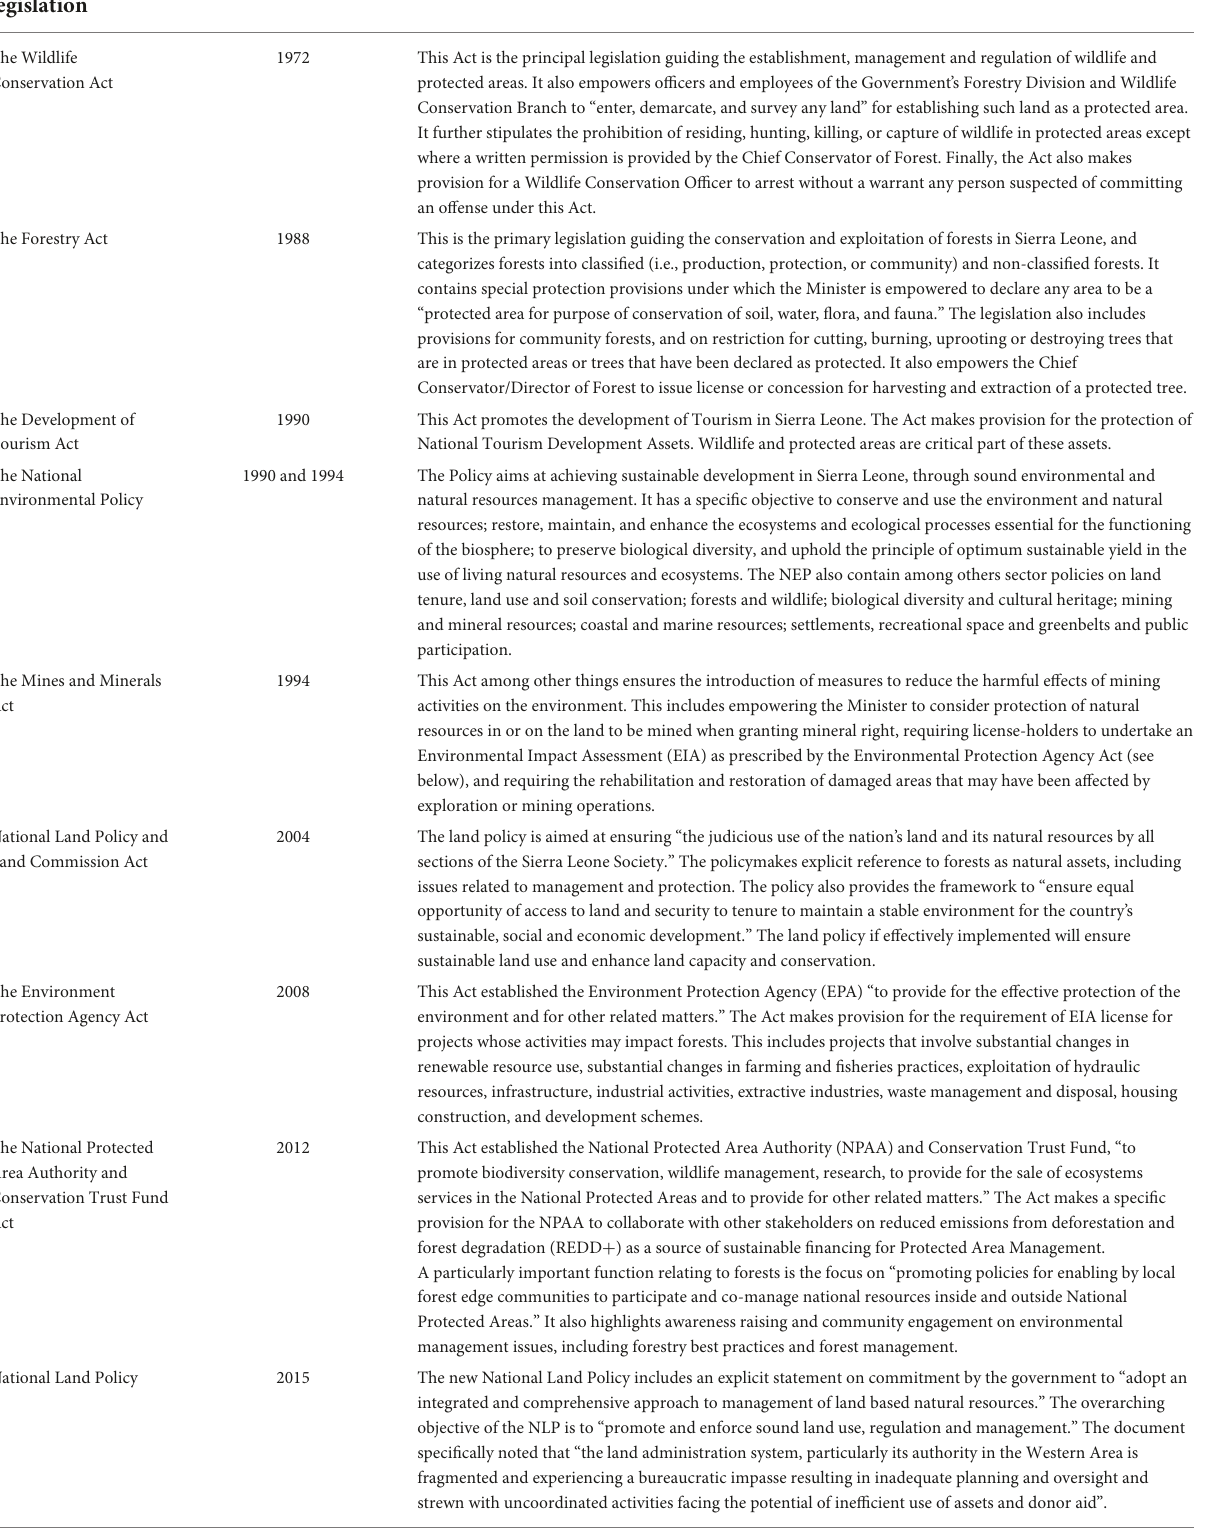
TABLE 1 National policies and legislation related to conservation of forest and tree-based